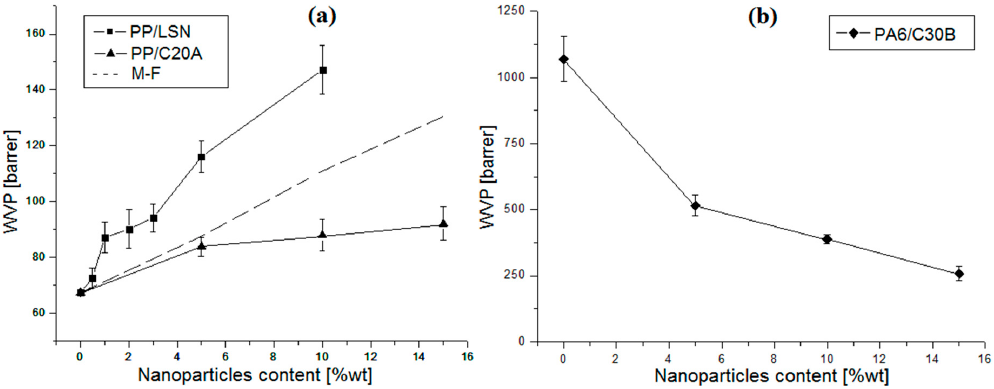
Figure 6. Water vapor permeability (WVP) of nanocomposites: ( a ) PP/LSN and PP/C20A; and ( b ) PA6/C30B.